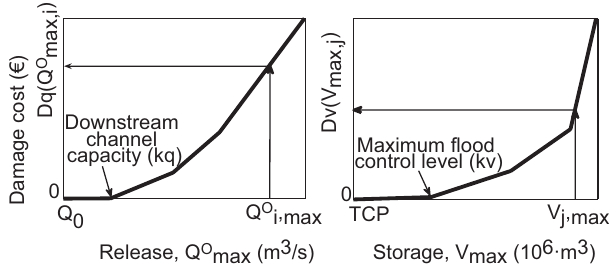
Fig. 4. Example of the relationship between damage and release (left) and damage and volume